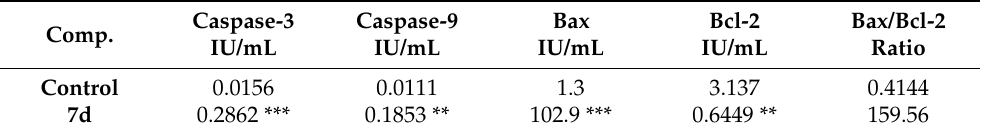
Table 3. Effect of N -benzylindolin-2-one derivative 7d on the active caspases-3 and -9 levels and the Bax and Bcl-2 expression levels in MCF-7 cells after treatment with 7d at its IC 50 concentration.